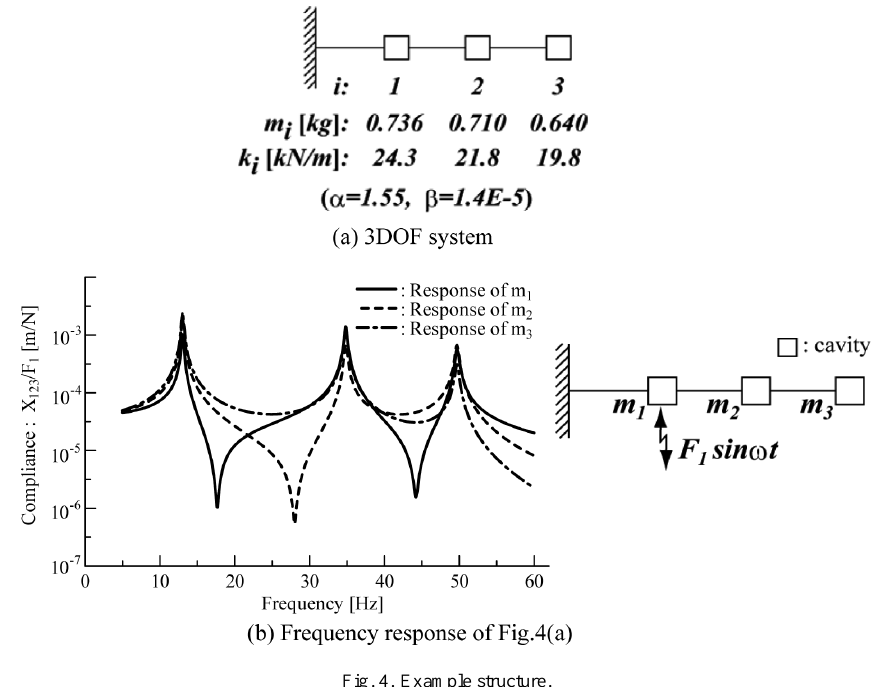
Fig. 4. Example structure.